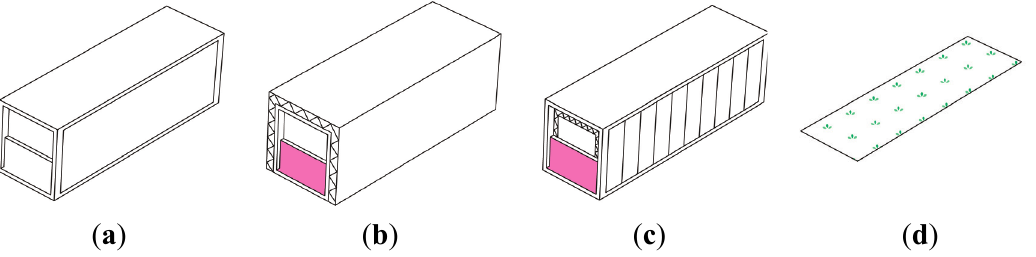
Figure 2. In search for a sustainable strategy to deal with the existing student residences,